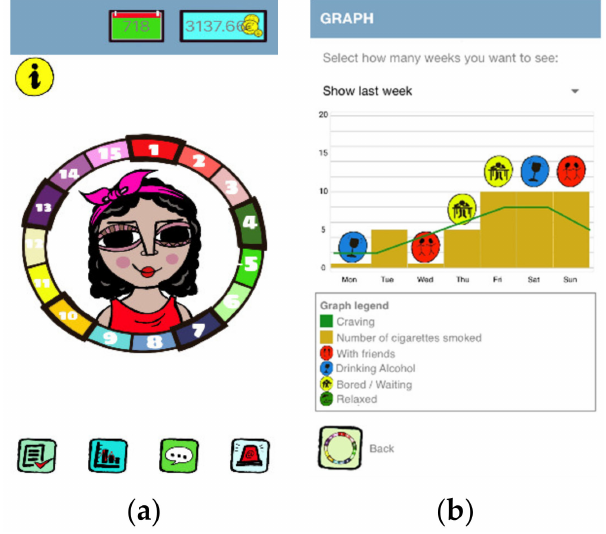
Figure 1. These figures show screenshot of NoFumo+ app: ( a ) main screen with treatment completed; ( b ) graphical resources describing smoking behavior